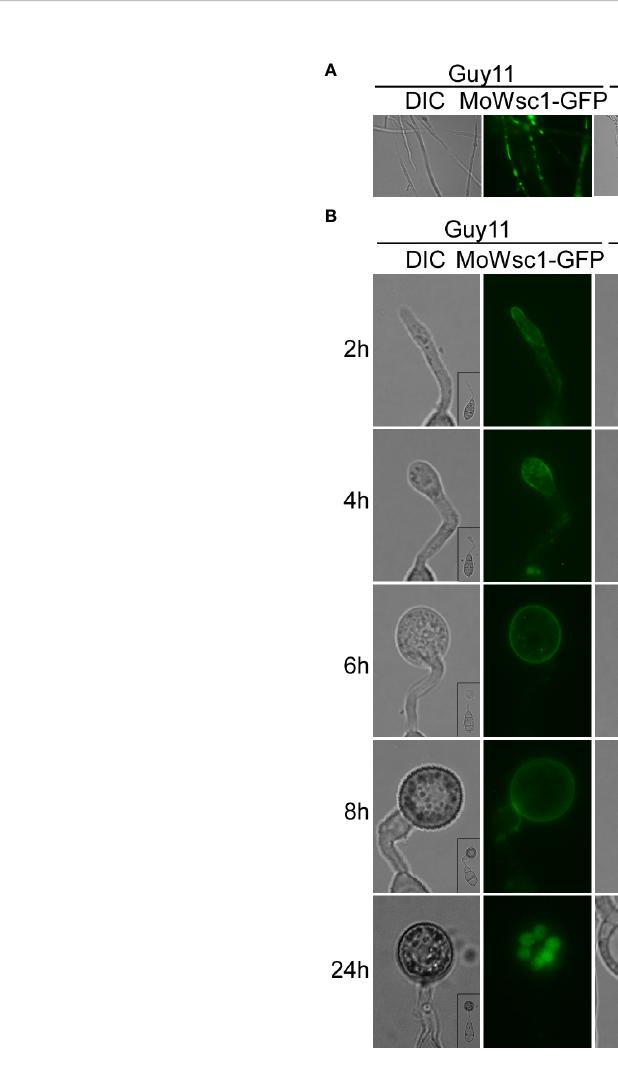
FIGURE 8 Cell wall integrity signaling pathway response proteins MoWsc1 respond to KC81 SUP. (A) Live cell imaging experiment to show MoWsc1-GFP localization in M. oryzae mycelium in the presence or absence of KC81 SUP. (B) Live cell imaging experiment to show MoWsc1-GFP localization during M. oryzae appressorium development in the presence or absence of KC81 SUP. Bar = 10 m